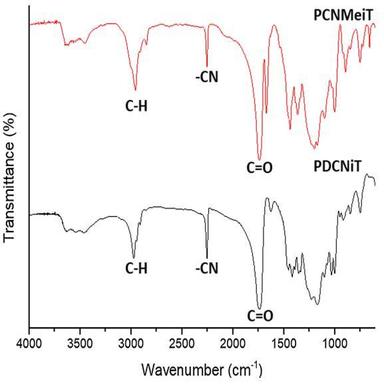
FTIR spectra of both poly(itaconate)s.